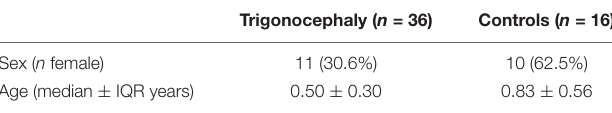
TABLE 1 | Patient characteristics.